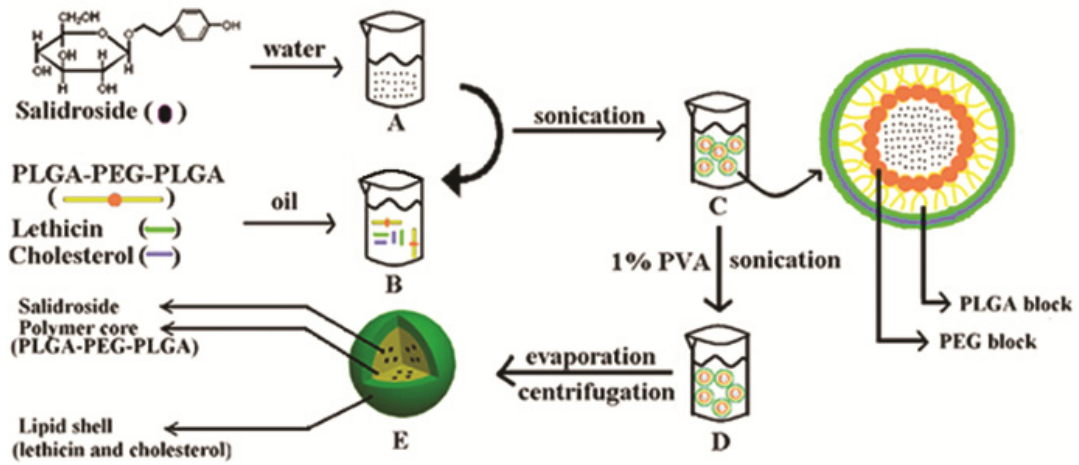
Figure 10. The schematic diagram of Sal-LPNPs preparation. Firstly, Sal was dissolved in water to form an internal aqueous phase ( A ); The organic phase was composed of PLGA-PEG-PLGA, cholesterol and lecithin in dichloromethane ( B ); Secondly, the internal aqueous phase was added into the organic phase to get the coarse emulsion by sonication ( C ); = 30–70 KD) solution was added into the coarse emulsion to further Thirdly, 1% PVA ( M W form W/O/W double emulsion by sonication ( D ); Then the organic solvent was removed by rotary vacuum evaporation. Lastly, free Sal was removed by centrifugation to get the Sal-LPNPs ( E